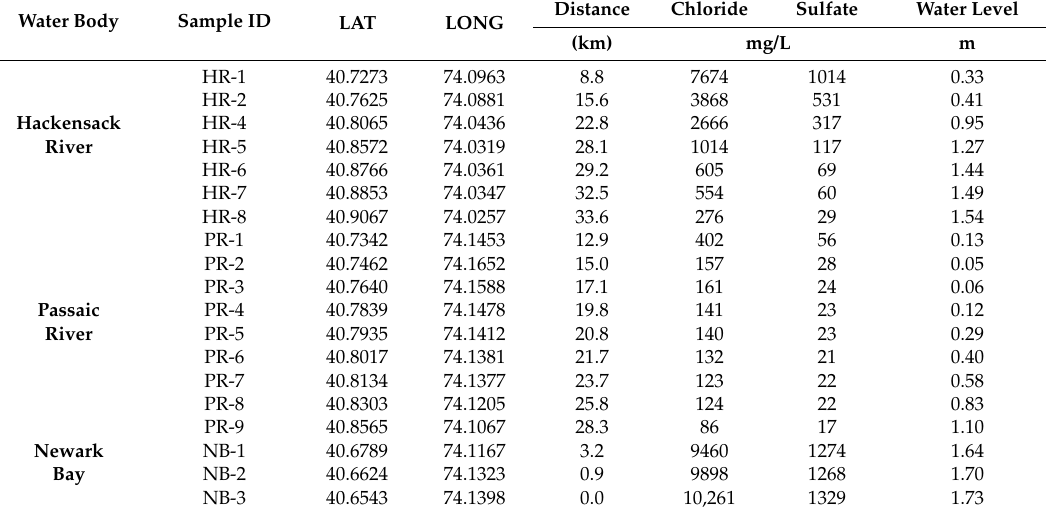
Table 2. Concentrations of chloride and sulfate in water samples collected from the Hackensack River, the Passaic River, and the Newark Bay in summer 2015. Distance (km) indicates the distance from NB-6 located near the mouth of the Newark Bay. Water level data (tidal datum: mean lower low water) at Bergen Point West Reach, NY, are from National Oceanic and Atmospheric Administration